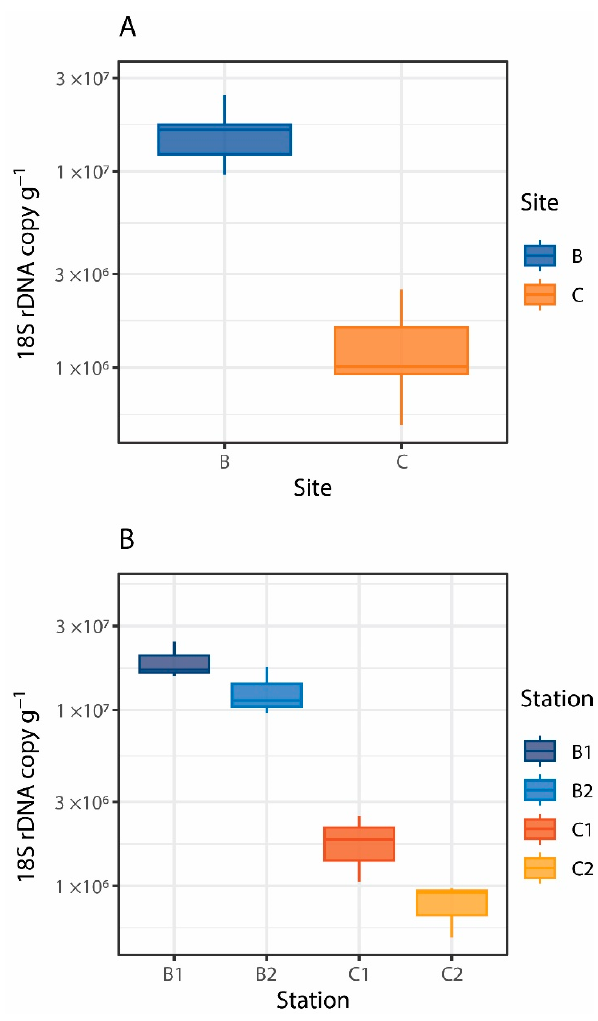
Figure 2. Boxplots showing fungal abundance, expressed as the number of 18S rDNA copies per gram of dry sediment, of the two benthic deep-sea sites investigated ( A ) and of the stations within sites B and C ( B ).